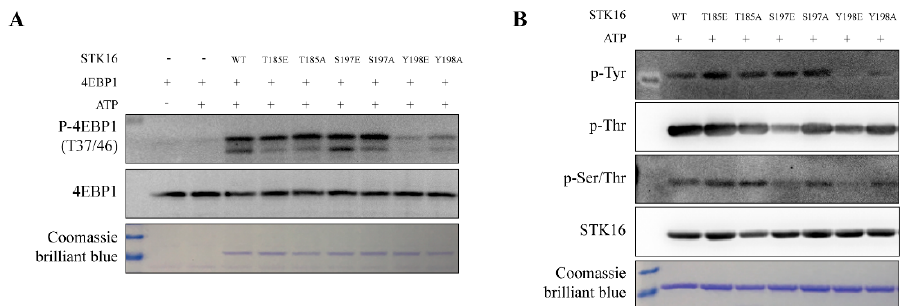
Figure 5. Tyr198 phosphorylation is important for the kinase activity of STK16. ( A ) In vitro , the mutation of Tyr198 significantly inhibited the phosphorylation of 4EBP1 by STK16. 300 nM STK16 or STK16 mutant proteins were incubated with 10 μ M 4EBP1 protein at 37 °C for 30 min in kinase buffer. The 4EBP1 and phospho-4EBP1 (T37/46) antibodies were used in Western blots. ( B ) The Tyr198 mutation reduced the Tyr kinase activity of STK16. 1 μ M STK16 or STK16 mutant proteins were incubated at 37 °C for 30 min in kinase buffer. p-Tyr, p-Thr, p-Ser/Thr, and STK16 antibodies were detected by Western blots. Coomassie brilliant blue stained STK16 and STK16 mutant proteins.